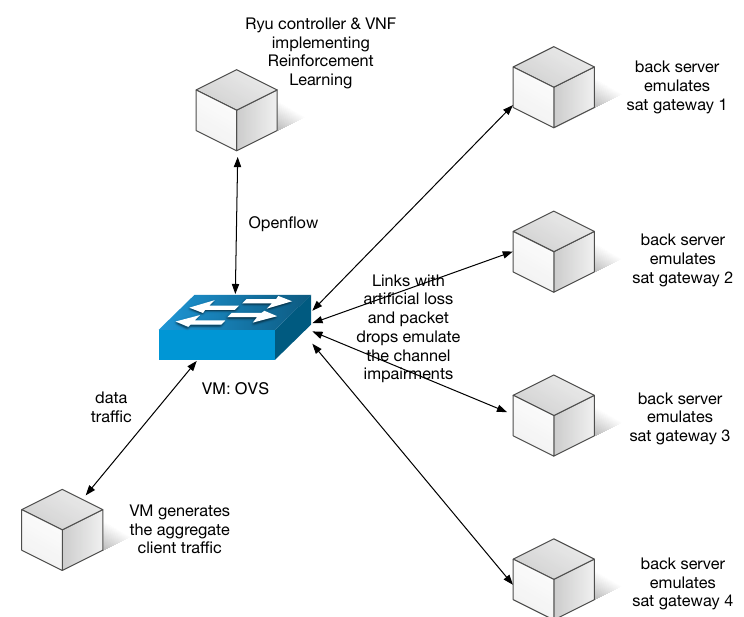
Figure 3. Emulated HTS system with VNF providing reinforcement learning-based routing.